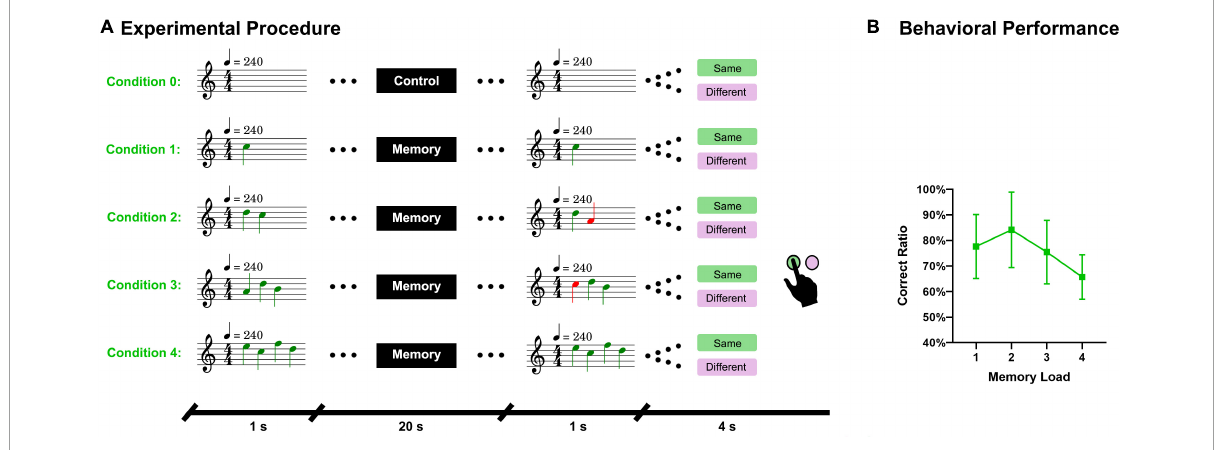
FIGURE1 Experimental procedure and behavioral results. (A) A sequence of piano tones (1–4 tones) was presented to subjects and after 20 s, another sequence of tones (same length) was presented. Subjects must answer whether these two sequences are the same. There were five conditions in total. Condition 0 referred to the control task, during which no sequence was presented and subjects had to answer “same” in the answer period. (B) Accuracy of the answers under different memory